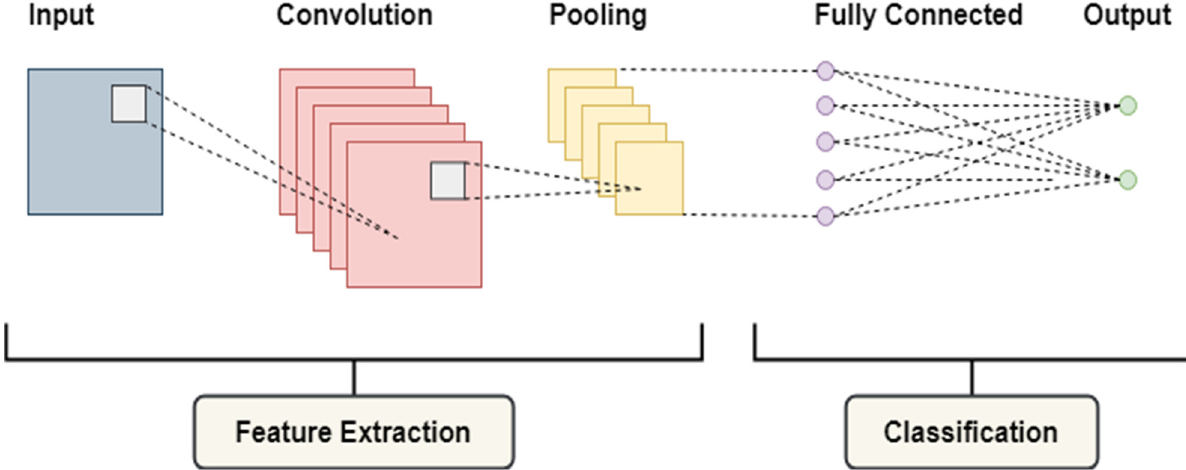
Figure 5. Architecture of the basic CNN approach.